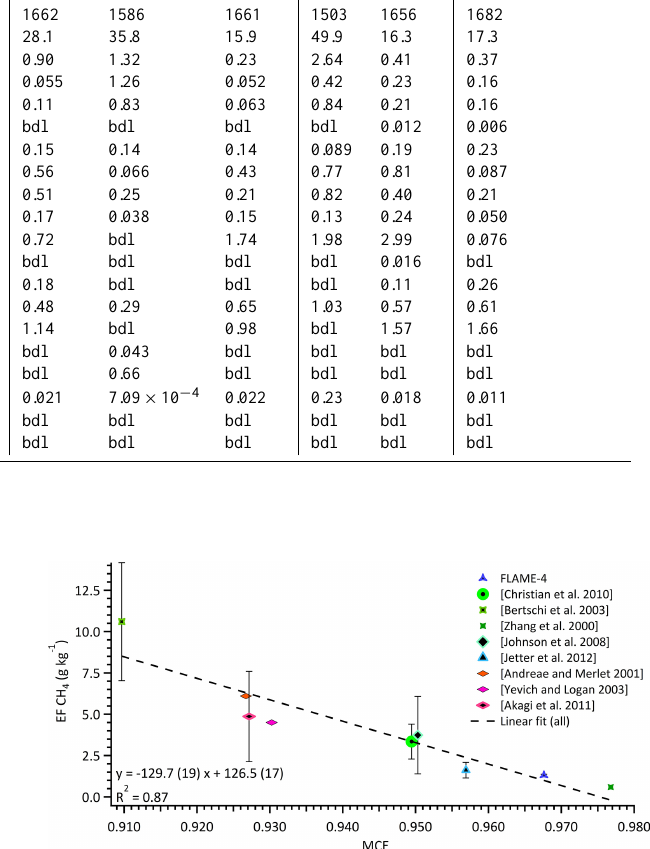
Figure 10. Open cooking fire, fire-averaged emission factors of CH 4 as a function of MCE for current and past laboratory and field measurements together with the recommended global averages. Er- ror bars indicate one standard deviation of the EF for each study where